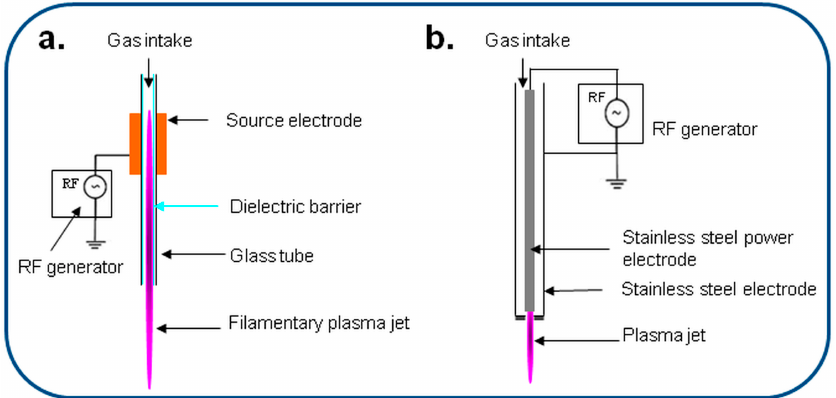
Figure 2. Configuration of plasma jet sources: dielectric barrier discharge (DBD) ( a ) and plasma torch (E) ( b ). Table 1. Conditions for dielectric barrier discharge (DBD) and plasma torch (E) plasma treatments of nanocellulose